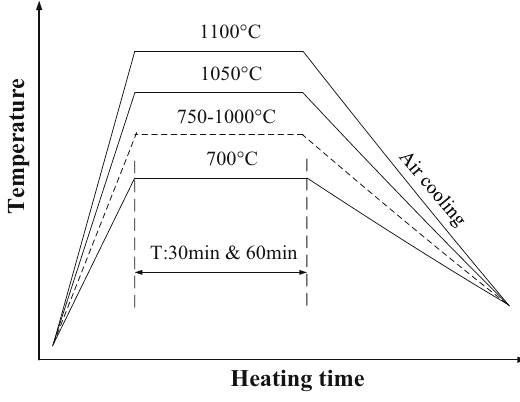
Figure 1: Heat - treatment process curves at varying